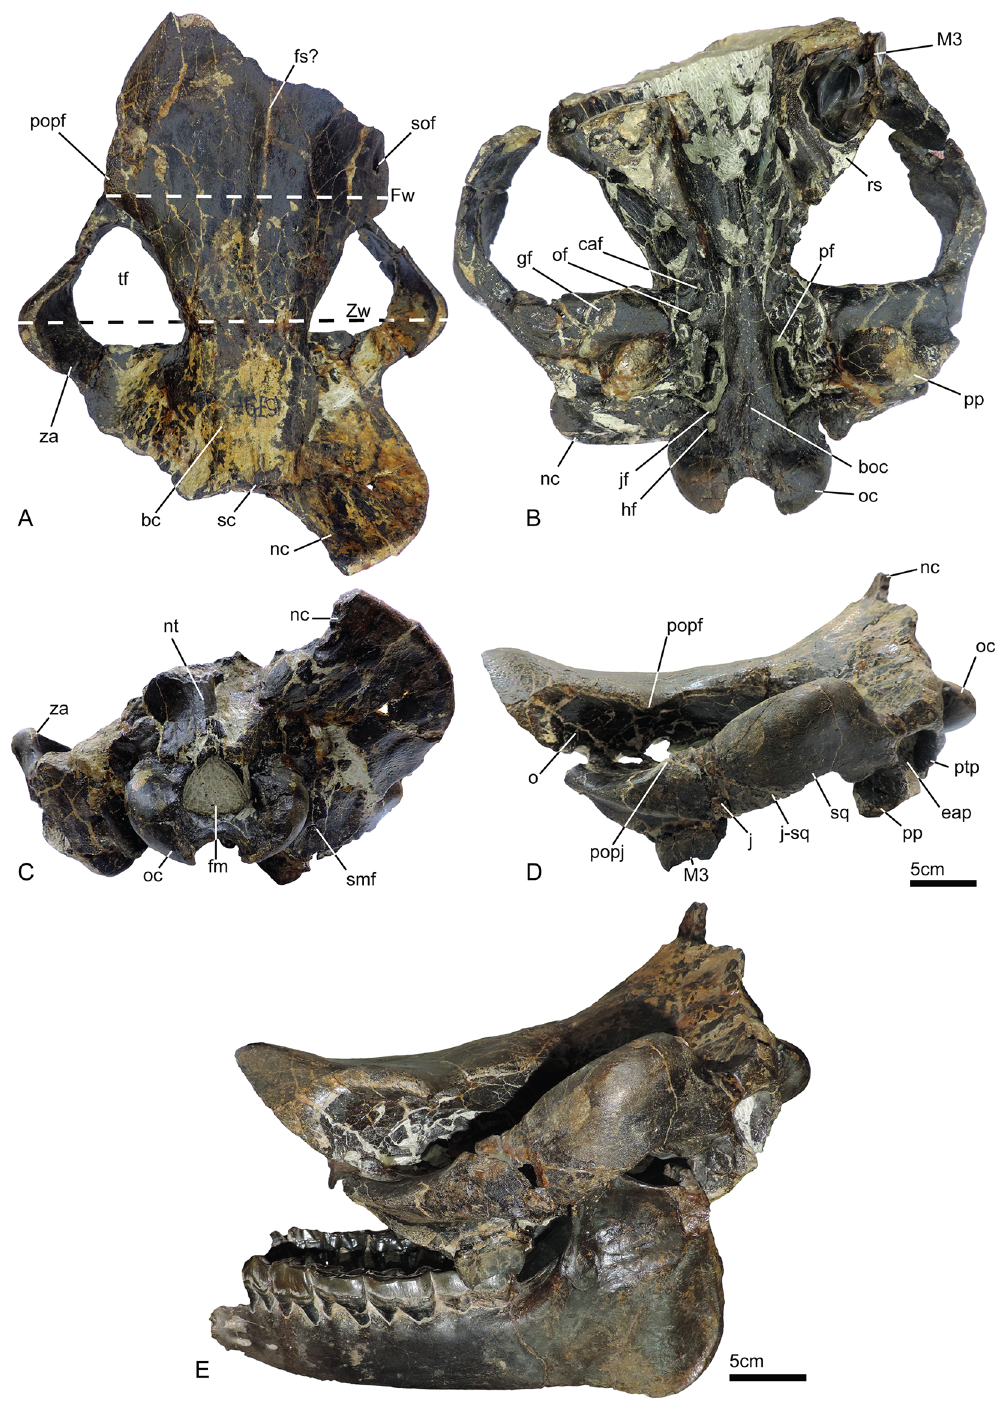
Fig 2. Skull of Sellamynodon zimborensis (holotype, UBB MPS 15795), a Late Eocene-Early Oligocene amynodontid from Dobaˆrca (Romania). Dorsal (A), ventral (B), lateral (C) and occipital (D) views. Skull and associated mandible in lateral view (E). Abbreviations: bc, braincase; boc, basioccipital crest; caf, caudal alar foramen; eap, external auditory pseudomeatus; fm, foramen magnum; fs?, frontals suture?; Fw, frontal width; gf, glenoid fossa; hf, hypoglossal foramen; j, jugal; j-sq, jugal-squamosal suture; jf, jugular foramen; nc, nuchal crest; nt, nuchal tubercle; o, orbit; oc, occipital condyle; of, oval foramen; pf, piriform fenestra; popf, postorbital process of the frontal; popj, postorbital process of the jugal; pp, postglenoid process; ptp, posttympanic process; rs, retromolar space; sc, sagittal crest; smf, stylomastoid foramen; sof, supraorbital foramen; sq, squamosal; tf, temporal fossa; za, zygomatic arch; Zw, zygomatic width.